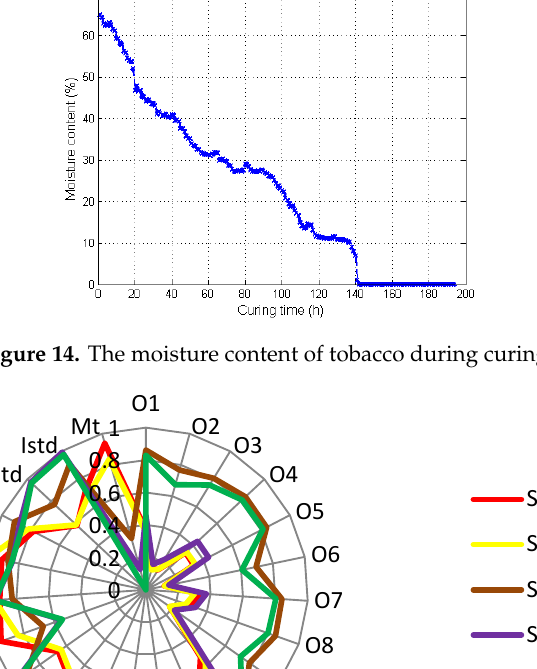
Figure 13. The raw images of tobacco leaves at the leaf-yellowing stage in the different curing phases: ( a ) early phase; ( b ) middle phase.